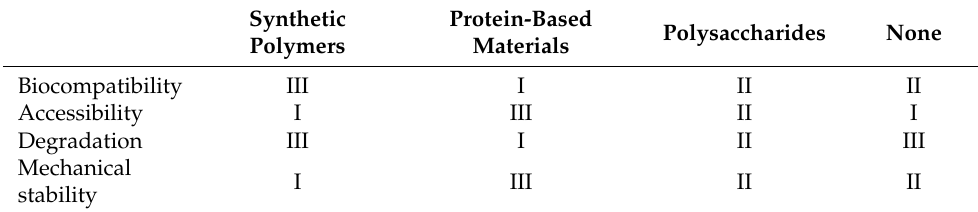
Table 2. Backbone-dependent properties of polyphenolic materials (order indication: I > II > III). Synthetic Protein-Based Polysaccharides Polymers Materials